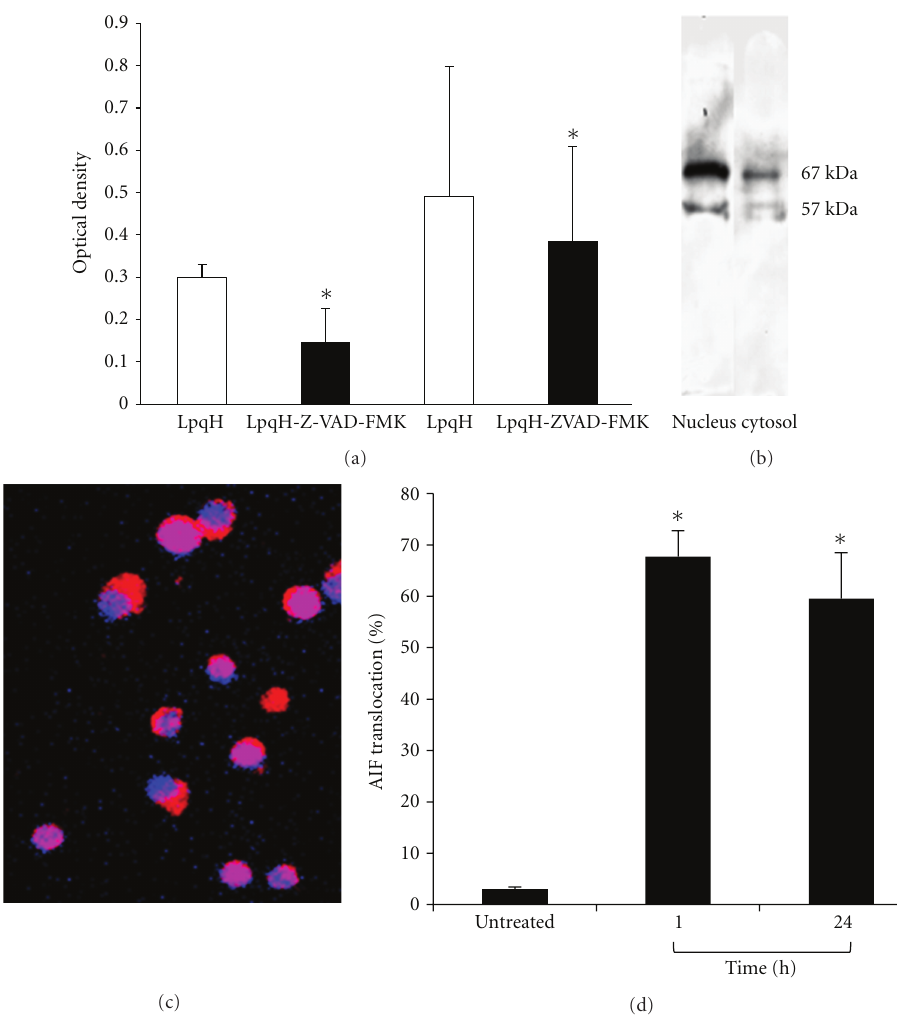
Figure 6: Caspase-independent mechanisms with AIF relocation are involved in LpqH-induced MO. (a) MOs were preincubated with the pancasphae inhibitor Z-VAD-FMK for 30min and thereafter apoptosis was induced with 5 μ g LpqH for 1 and 24h; apoptosis was measured by a nucleosome ELISA kit. At 1h apoptosis (left) inhibition was of 49.08% and at 24 h of 19.41% (right). Data from four independent experiments are expressed as mean ± SE of the optical density found; ∗ P < 0 . 05. (b) Cells, untreated or treated with LpqH for 24 h, were subjected to subcellular fractionation and immunoblot with a mAb to human AIF using cytosolic and nuclear fractions. (c) For immunofluorescence, after 1 and 24h apoptosis induction, MOs were incubated with a mAb to human AIF labeled with CY5 (red fluorescence); nuclei were labeled with DAPI (blue fluorescence). By confocal microscopy, photographs were taken at the midsection of at least 100 cells per condition; photographs were analyzed and merged using the National Institutes of Health ImageJ software (Bethesda, MD, USA). AIF is seen in nuclei as magenta fluorescence frequently massive resulting from the colocalization of CY5 and DAPI; × 40, original magnification. (d) Epifluorescence was used to estimate the percentage of cells showing AIF nuclear translocation at 1 and 24 h; at least 500 cells randomly chosen were photographed and analyzed with ImageJ; ∗ P < 0 .